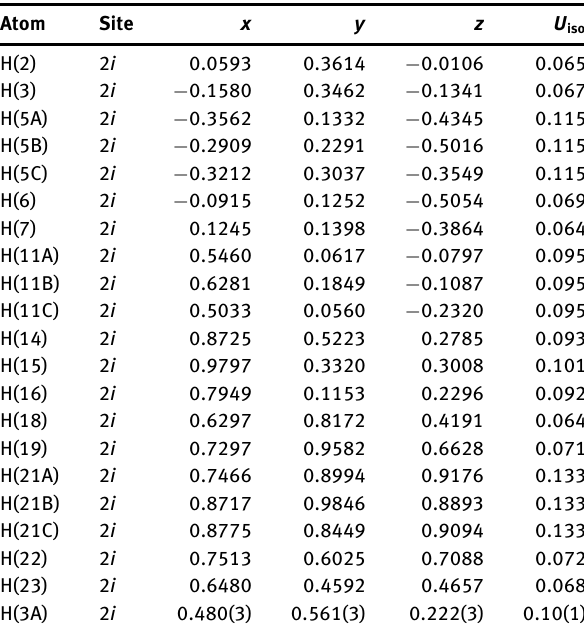
Table 2: Fractional atomic coordinates and isotropic or equivalent isotropic displacement parameters (Å 2